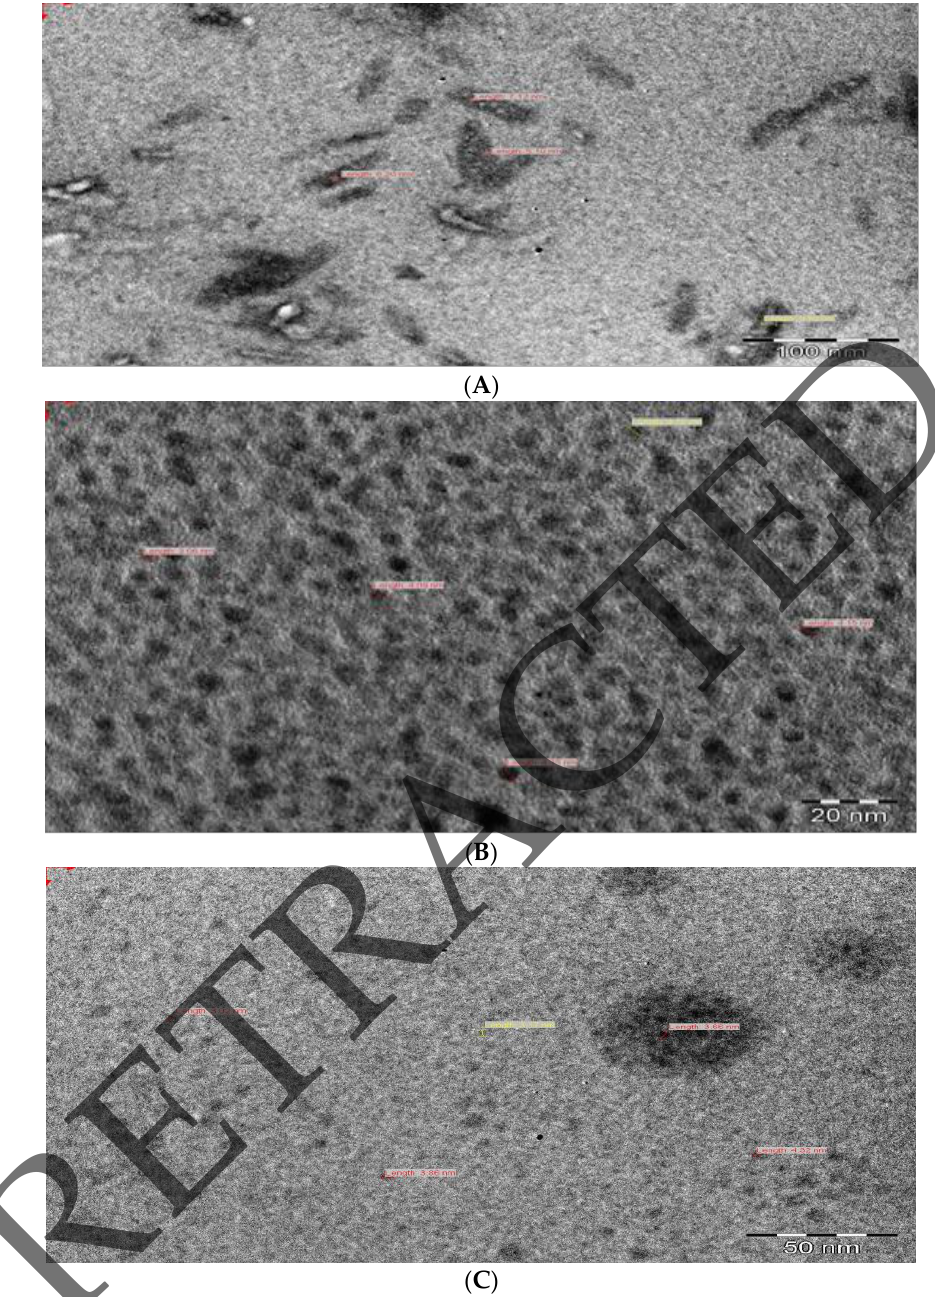
Figure 4. Transmission electron microscopy (TEM) images of CuS1 ( A ), CuS2 ( B ), and CuS3 ( C ) nanoparticles.